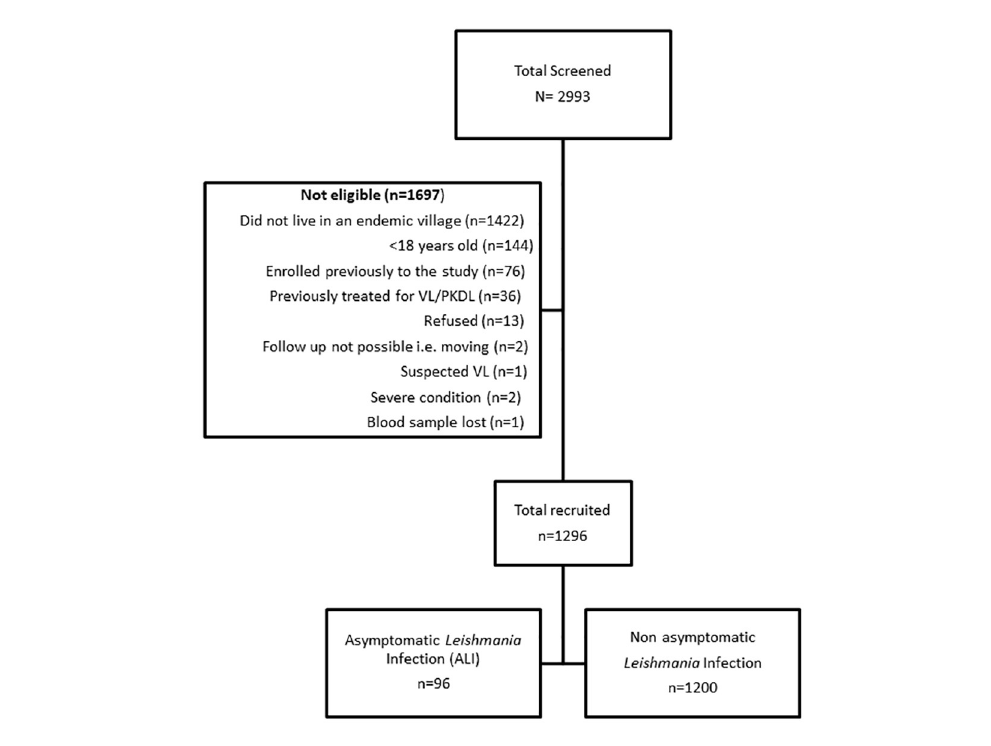
Fig 1. Flow diagram showing recruitment of study participants in Bihar, India between May 2018 and June 2019.